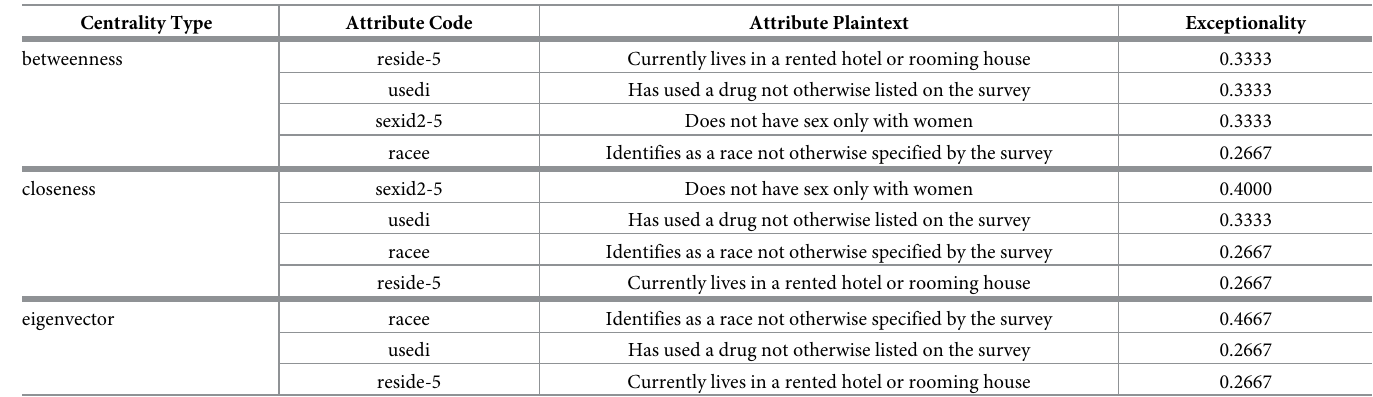
Table 2. Exceptional attributes of Los